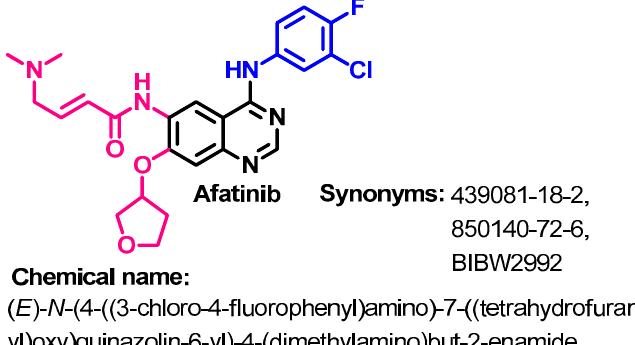
Figure 7. Chemical structure/name/synonyms of afatinib.